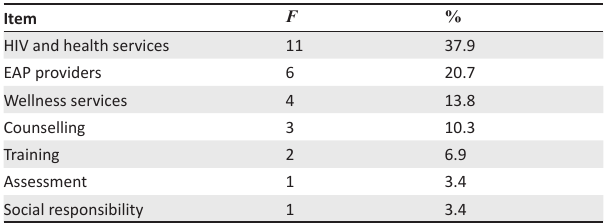
TABLE 9: Main activities on which organisations spend their budgets for Employee Wellness Programmes.